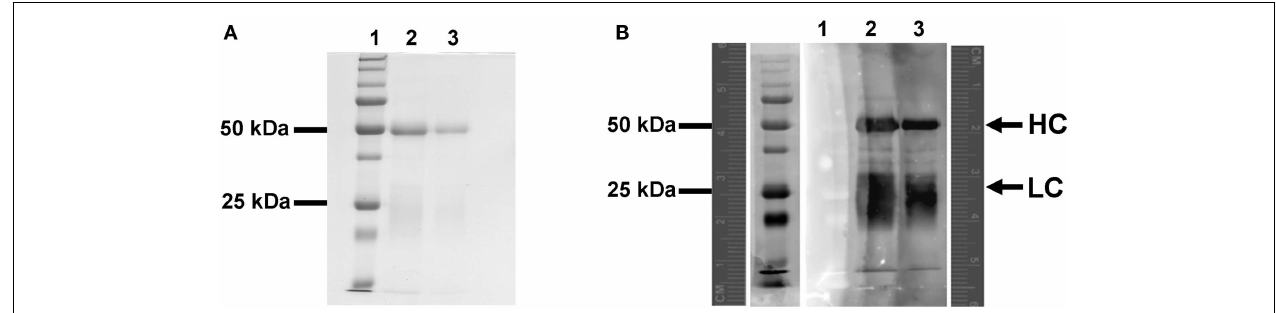
the immediate left of lane 1 in (B) is an image of lane 1 captured under transmitted light); lanes 2 and 3, 3 and 1 µ g of B- α IgG, respectively. A pair of fluorescence rulers is included in (B) to provide a reference for the migration distance of proteins detected under fluorescence and transmitted light.The positions of the 50 and 25kDa prestained protein standards, and the heavy (HC) and light-chain (LC) polypeptides of B- α IgG are indicated.